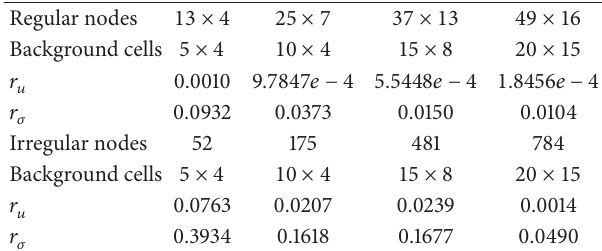
Table 3: Convergence study for Example 4.1